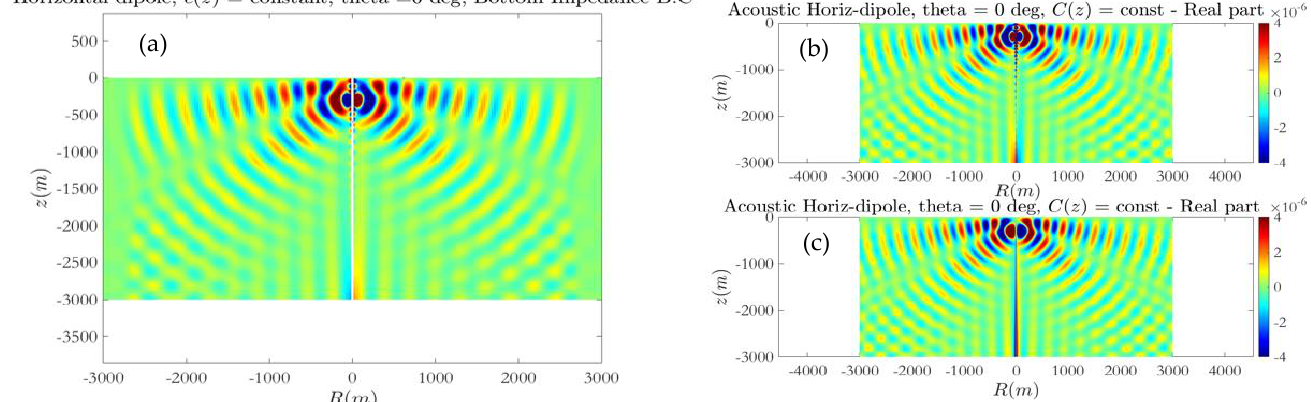
Figure 17. ( a ) The acoustic field obtained using the solution of the FDTD – PML numerical scheme excited by a vertical dipole source of frequency located at a depth of 300 m with an impedance bottom boundary condition in an isovelocity environment. ( b , c ) Real and imaginary parts of the acoustic field obtained using the solution of the Helmholtz equation excited by a vertical dipole source of frequency